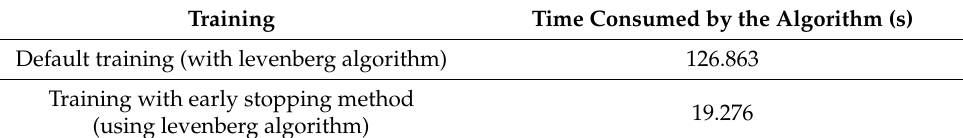
Table 2. Time consumption of learning for artificial neural networks with and without early stopping. Training